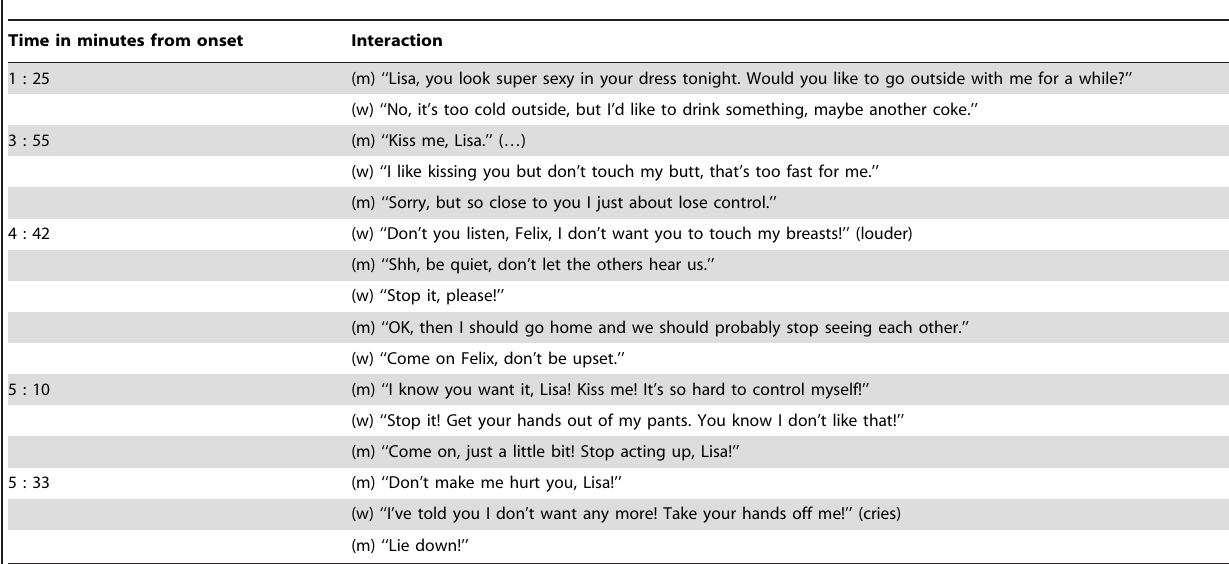
Table 1. Excerpts from the vignette used in the risk recognition task.